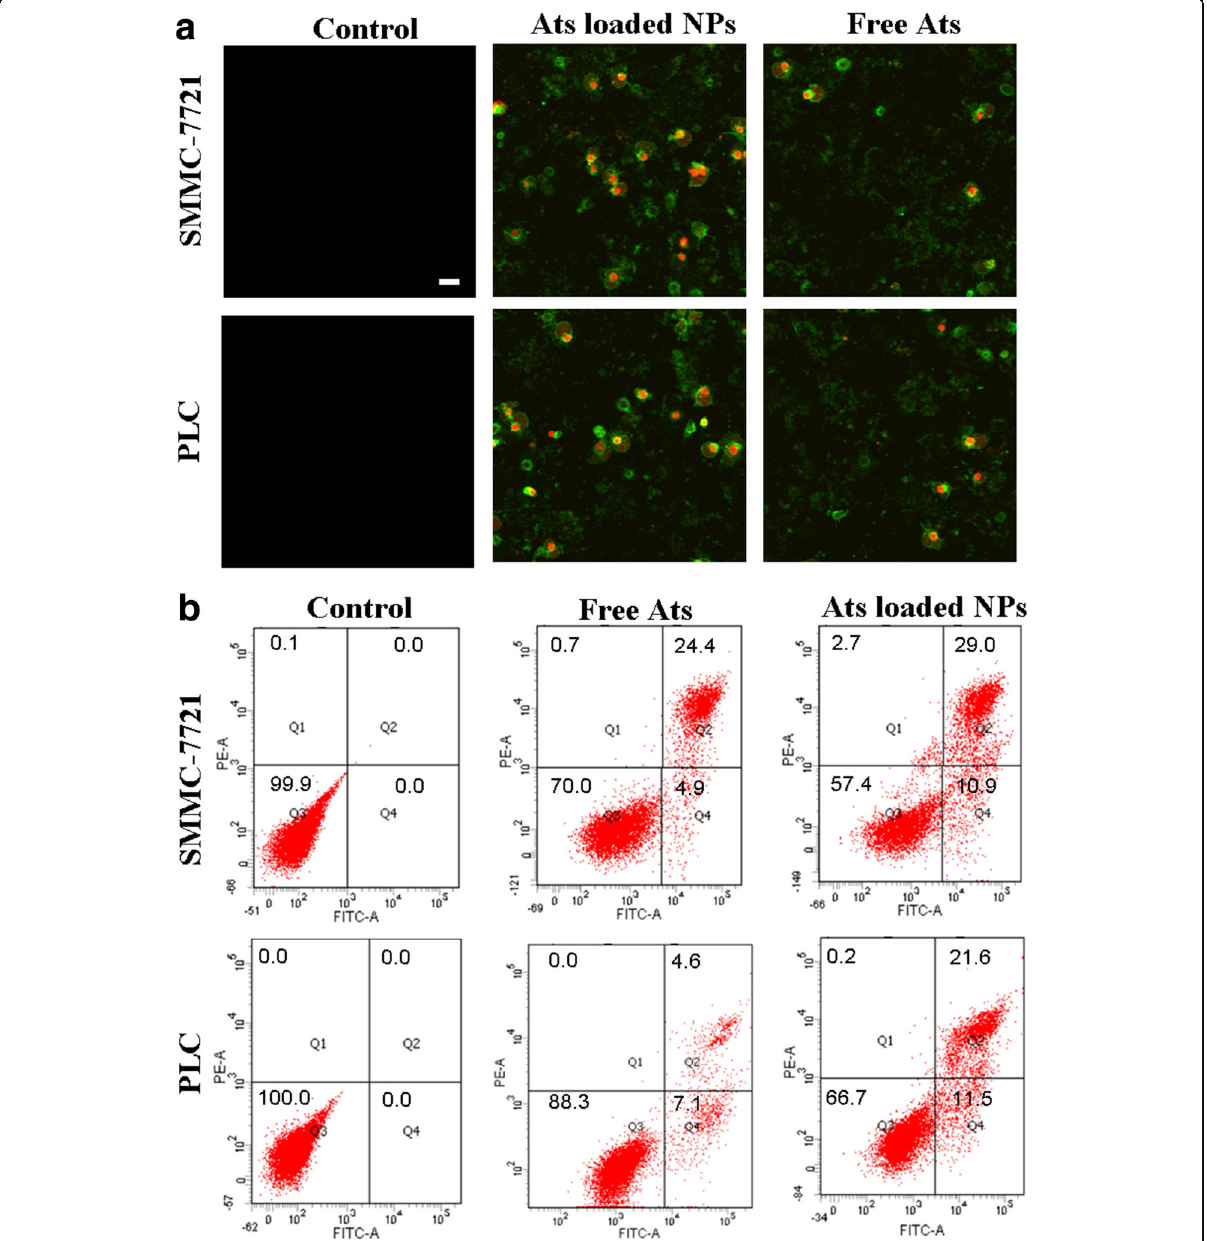
Fig. 5 Morphology of the ultrastructural changes of cells treated with free Ats and Ats-loaded BSA NPs using Annexin V-FITC/PI staining assay ( a ). Scale bar , 100 μ m. Flow cytometer analysis of the cellular apoptosis and oncosis after 24 h of incubation with the free Ats and Ats-loaded BSA NPs, respectively ( b